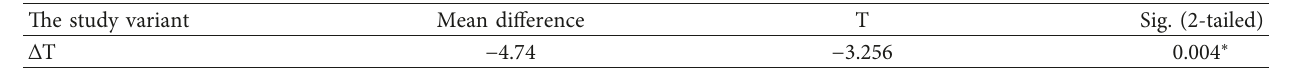
Table 5: Confidence intervals (CIs) for the means of ∆ T between groups A and B. The study